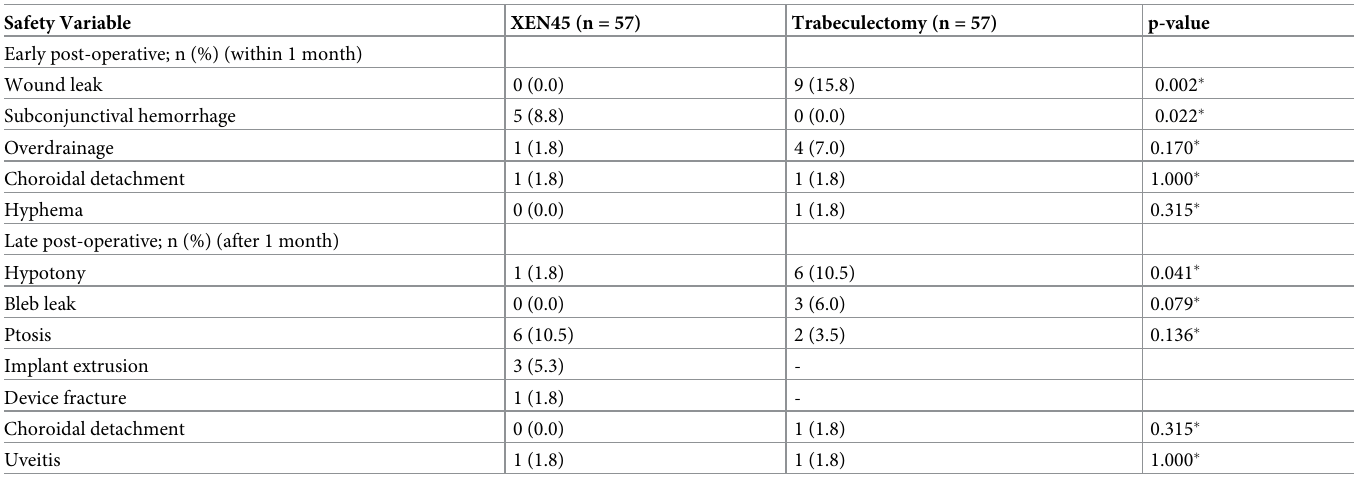
Table 3. Selected safety profiles of the XEN45 and trabeculectomy